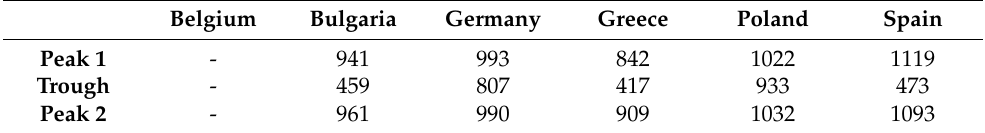
Table 4. Number of steps in significant peaks 1, 2 and in significant trough 1 during weekend